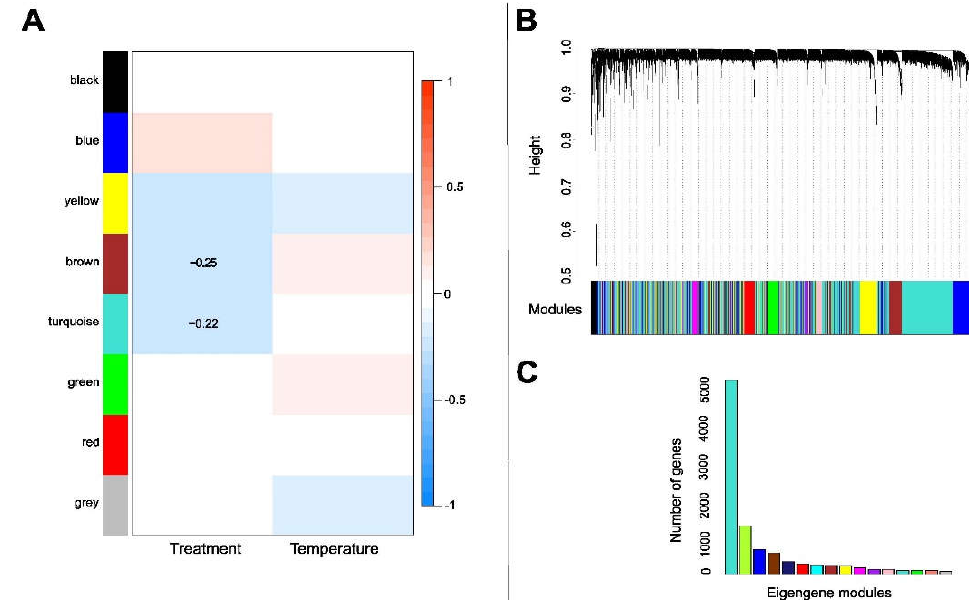
Figure 6. ( A ) Module traits in Symbiochloris reticulata , the photobiont of Lobaria pulmonaria . The correlation coefficients for each intersection of the corresponding row and column modules are given. The color in boxes represents –log (P), the correlation coefficient of significant correlations according to the color legend on the right. Modules are represented by the different colors on the left side. Two modules were associated with treatment (brown + turquoise) ( p < 0.005). ( B ) Co-expression network analysis of different samples in the photobiont of L. pulmonaria . Hierarchical cluster tree showing co-expression modules based on WGCNA. Each leaf in the tree corresponds to an individual gene. The branches correspond to modules of highly interconnected genes. The y axis represents the level of intramolecular connectivity, and genes that are located at the tip of the module branches have higher interconnectedness with the rest of the genes in the module. The differently colored bars below the dendrograms indicate module membership. ( C ) Number of eigengenes per